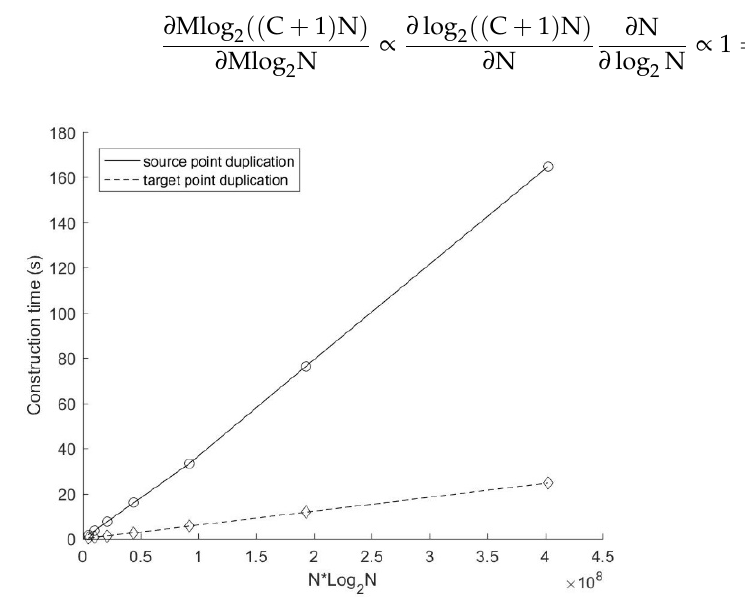
Figure 4. Construction time with different number of source points.